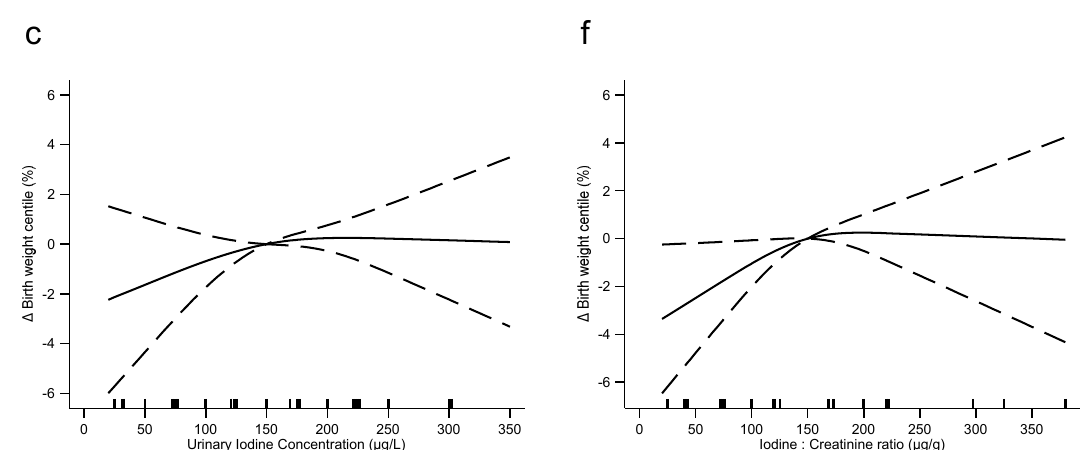
Figure 3. Urinary iodine concentration ( a – c ), iodine to creatinine ratio ( d – f ) and birth weight centile, dichotomous ( a , d ), linear ( b , e ), and nonlinear ( c , f ) meta-analyses. CI: Confidence interval; ∆ : Change in outcome